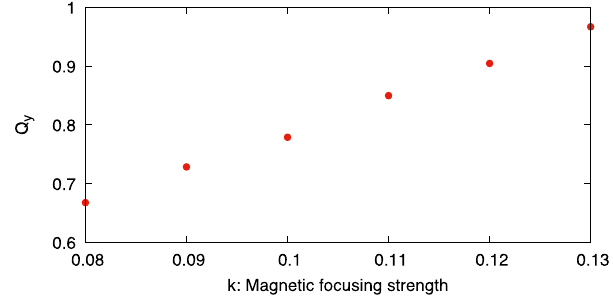
FIG. 8. The vertical spin precession rate as a function of the ¼ 1 =Q 2 P when the background effect is due to a combination y m of a DC ( N ¼ 0 ) radial magnetic field around the ring with strength of 1 pTand a large electric focusing effect of the bending plates. The bending plate focusing corresponds to an (electric) vertical focusing field index of m ¼ 0 . 1 . The fit result is from a first order polynomial. The DC-offset corresponds to the EDM precession rate, which in this case is − 1 . 9 × 10 − 8 rad = s, con- sistent within the estimated errors to the input EDM value corresponding to − 4 . 1 × 10 − 8 rad =